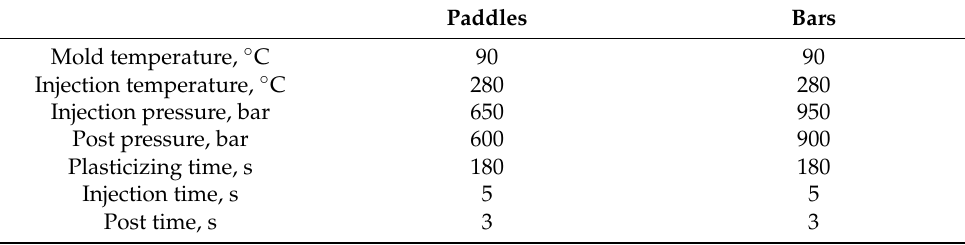
Table 3. Selected injection parameters.